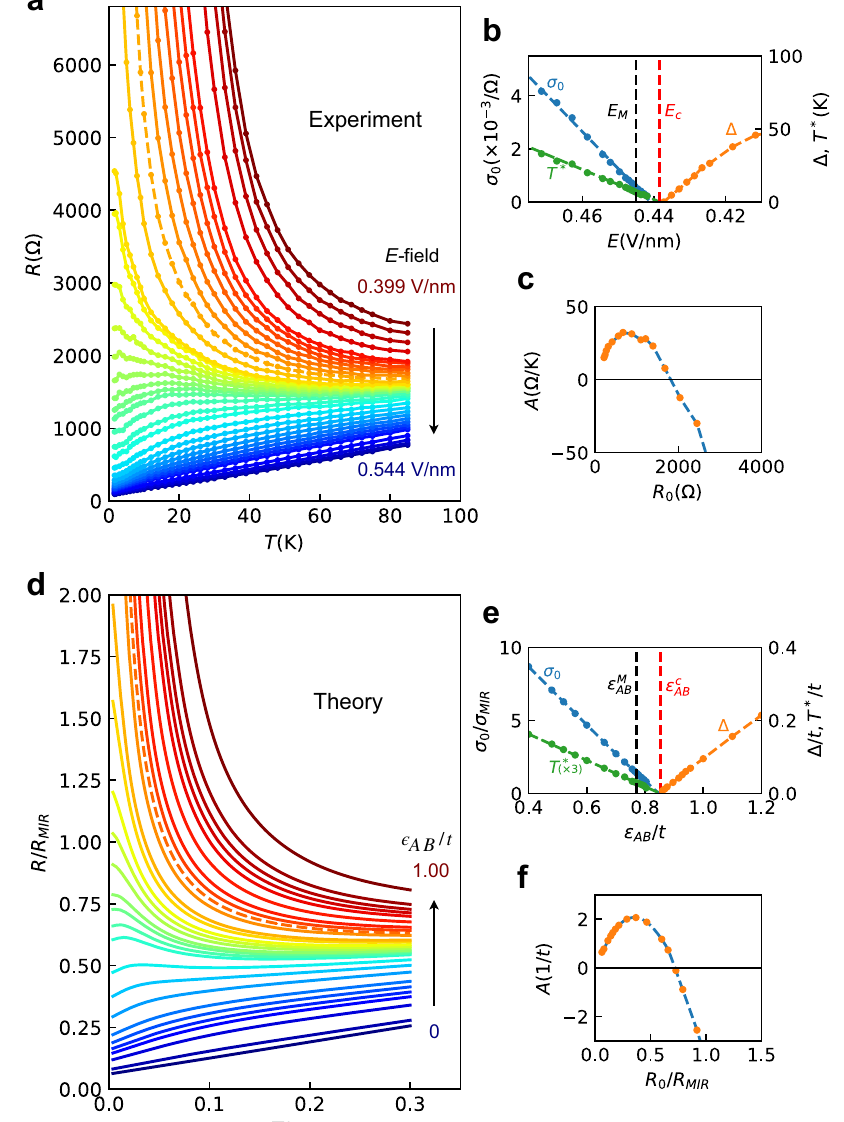
Fig. 1 | Transport behavior across the MIT at integer band fi lling. All the quali- tative features found in experiments (upper panel)arecaptured by our CPA-DMFT theory (bottom panel). a Experimental R ( T ) curves provided by experimental group 12 , with 0.399V/nm ≤ E ≤ 0.544V/nm; d theoretical curves for 0 ≤ ϵ AB / t ≤ 1.00. Thedashedlinesin a , d arecriticalcurves R c .Theinsets b , e ,showtheextrapolated T =0conductivity σ 0 ,theboundaryoflinearresistivityregion T * ,andtheactivation